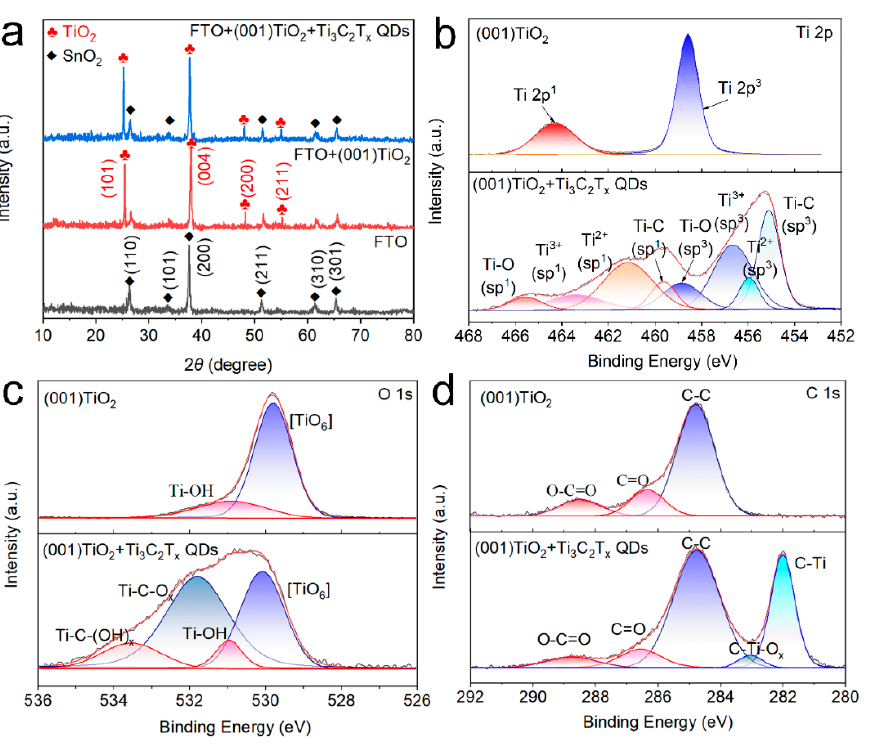
eV (2p 1/2 ). After loading Ti 3 C 2 T x QDs, the peak components of Ti 2p 3/2 and 2p 1/2 centered from low binding energy to high binding energy were attributed to the Ti-C, Ti-X from substoichiometric TiC x (x < 1) or Ti 3 AlC 2 , Ti 2+ ions and Ti 4+ ions, respectively [21]. The spec- trum of O 1s had two peaks located at 530.98 and 529.83 eV (Figure. 3c), which were as- signed to the Ti–OH species and the lattice oxygen [Ti-O 6 ] species. As for the O 1s XPS spectra after Ti 3 C 2 T x QDs were loaded, two new peaks were found at 531.78 and 533.58 eV, ascribed to the Ti-C-OH and Ti-C-O species, demonstrating the surface groups of Ti 3 C 2 T x QDs were O and − OH [22]. The C 1s of (001) TiO 2 can be divided into three char- acteristic peak components located at 288.4 eV, 286.5 eV, and 284.7 eV, which can be as- signed to O-C=O, C=O, and C ‒ C. Compared with pure TiO 2 , the introduction of Ti 3 C 2 T x QDs led to the appearance of two new characteristic peaks. The characteristic peak at 282.3 can be assigned to the Ti-C inside the Ti 3 C 2 T x QDs. Interestingly, compared with (001) TiO 2 composite, a new component appeared at 283.03 eV after the self-assembly process, which could be assigned to the C − Ti − O x bonding at the interfaces between Ti 3 C 2 T x QDs and (001) TiO 2 (Figure 3d) [23]. We believe that the O and -OH on the surface of Ti 3 C 2 T x may act as rivet sites to connect to the five coordinated titanium atoms in (001) of TiO 2 and form an atomic-scale interfacial heterojunction between 0D Ti 3 C 2 T x QDs and 2D TiO 2 NSs. 3.4. PEC Performance Characterization of Ti 3 C 2 T x QDs/(001) TiO 2 /FTO Electrode To evaluate the catalytic ability of the materials to catalyze AA, time-resolved current response curves were obtained in an aqueous O 2 -saturated PBS solution containing AA (0.1 M) under light irradiation (365 nm). In Figure 4a, the photoelectric response of TiO 2 NSs significantly improved after loading Ti 3 C 2 T x QDs. To explain the enhanced catalytic